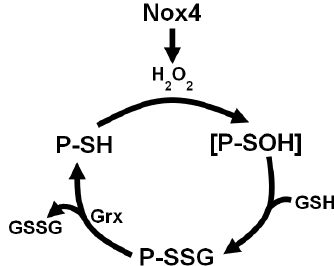
O ) oxidizes a protein thiol (P-SH) to 2 2